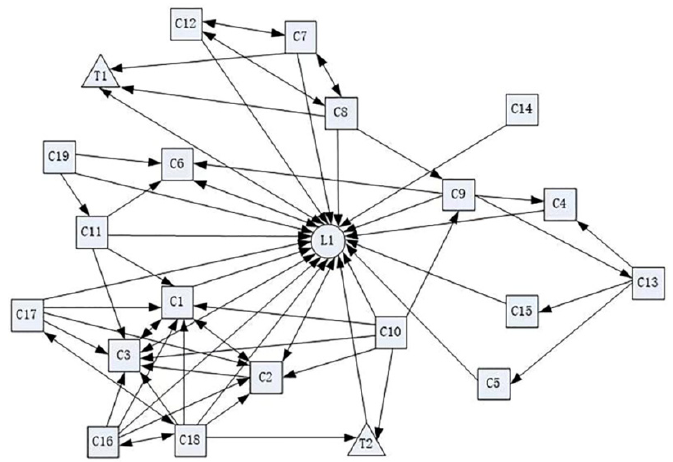
Figure 2. The knowledge transfer network of the reinforcement team.